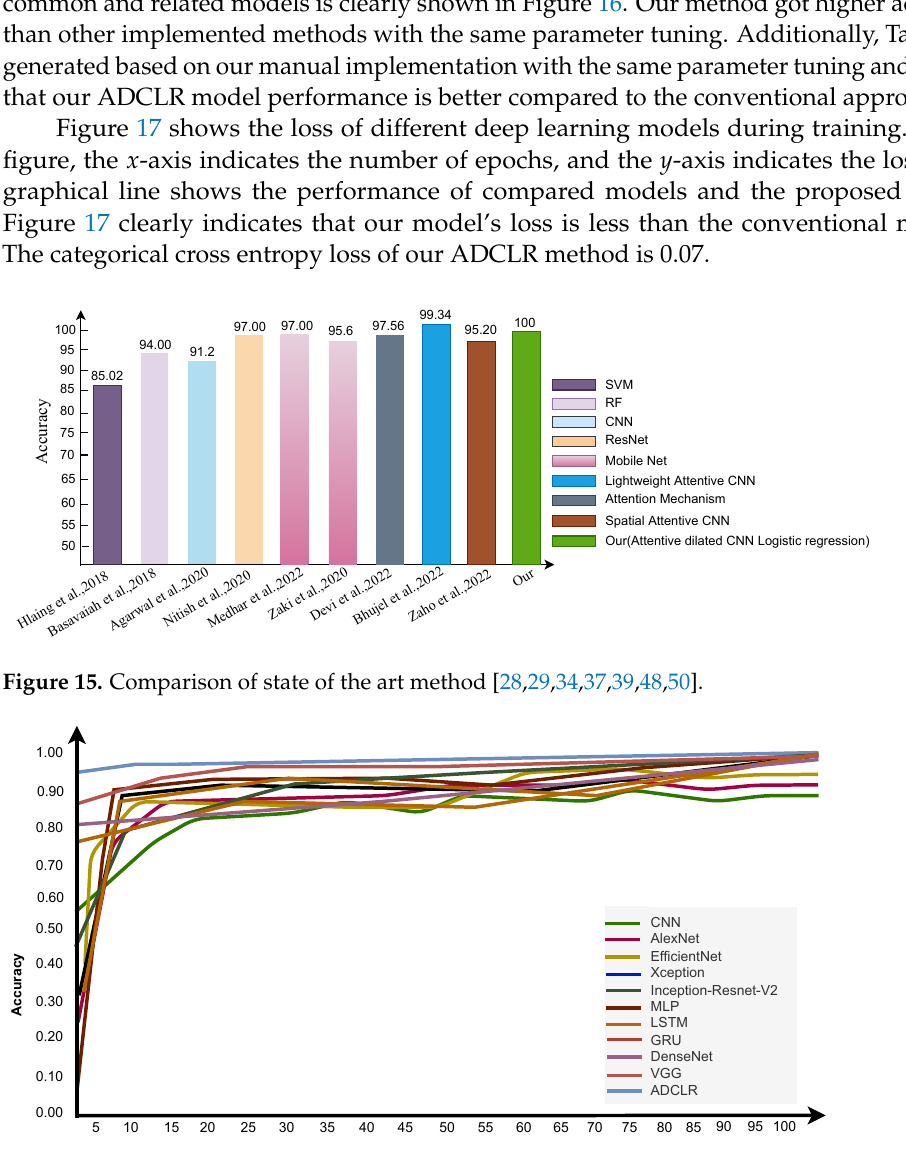
Figure 16. Accuracy comparison of the implemented deep learning models during training.